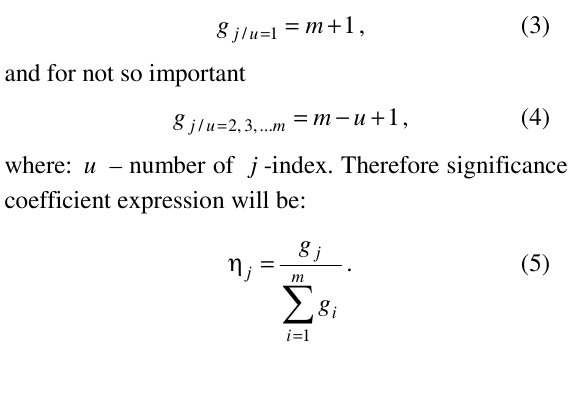
Table 2. Evaluation of technology adequacy for gathering required information Technology